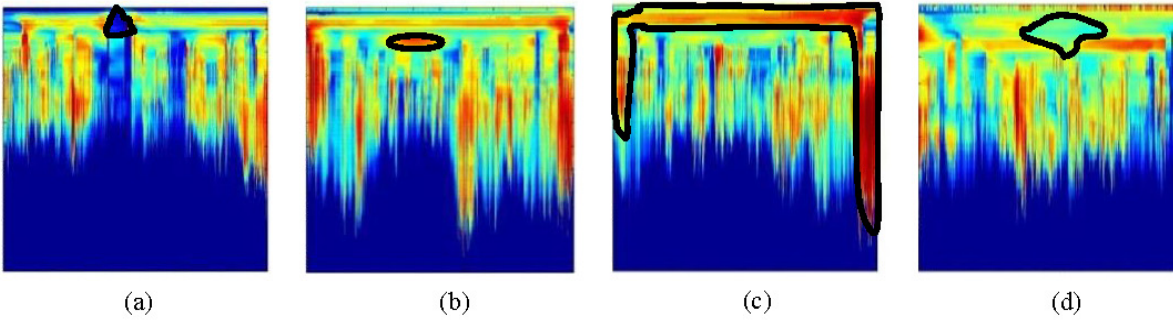
Figure 12. Identifiable target forms in pre-processed images in Section 5.2 and 5.3: ( a ) conical shape for water input (WI) and output (WO); ( b ) ellipse; ( c ) tank and measuring plate contours; and ( d ) water leak